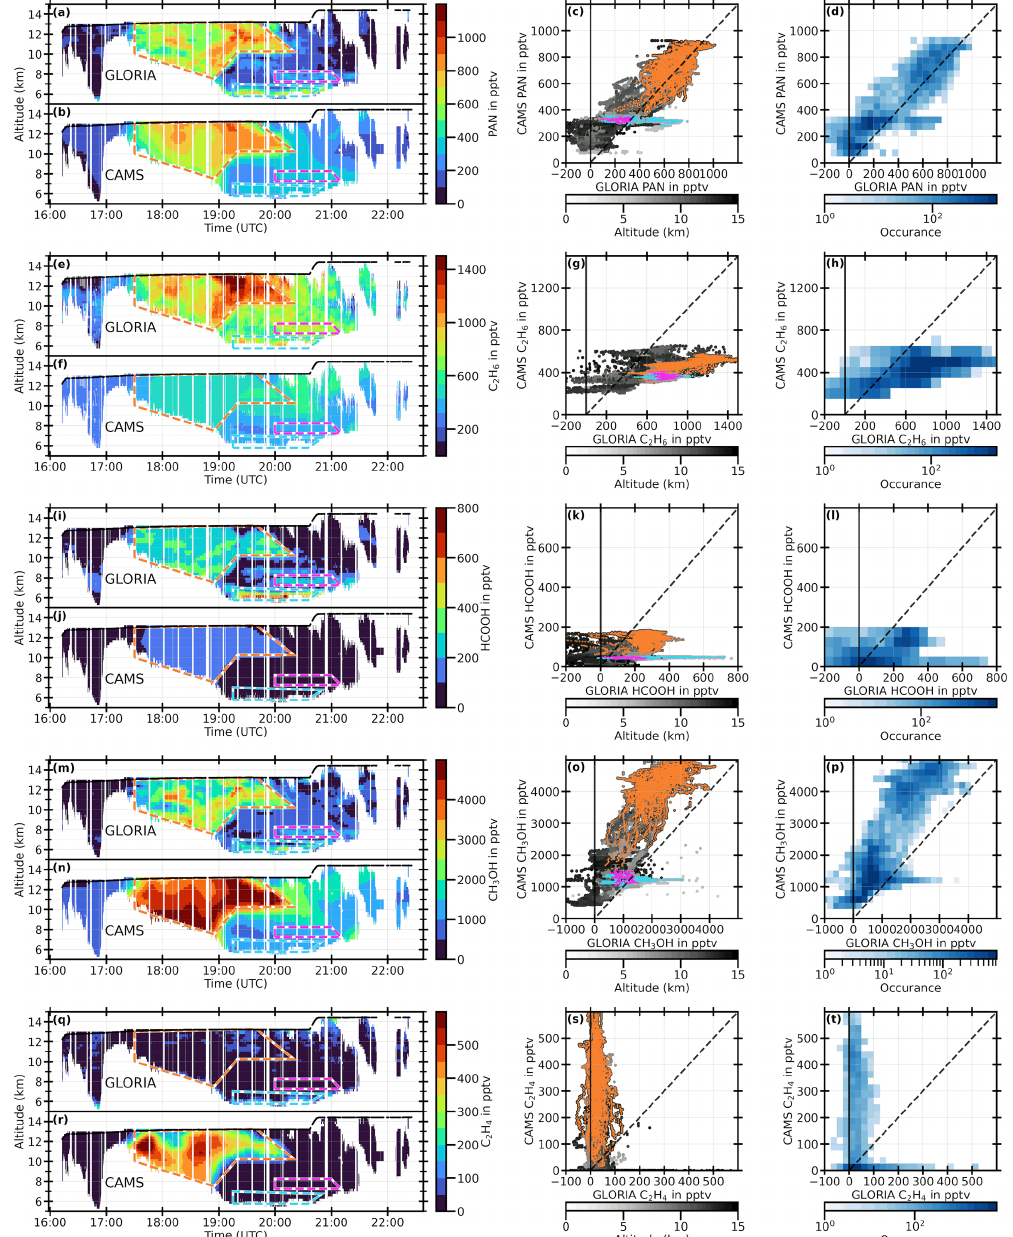
Figure 5. Same as Fig. 4, but for SouthTRAC flight on 7 October 2019. Note that colorbars may have changed compared to Fig. 4.